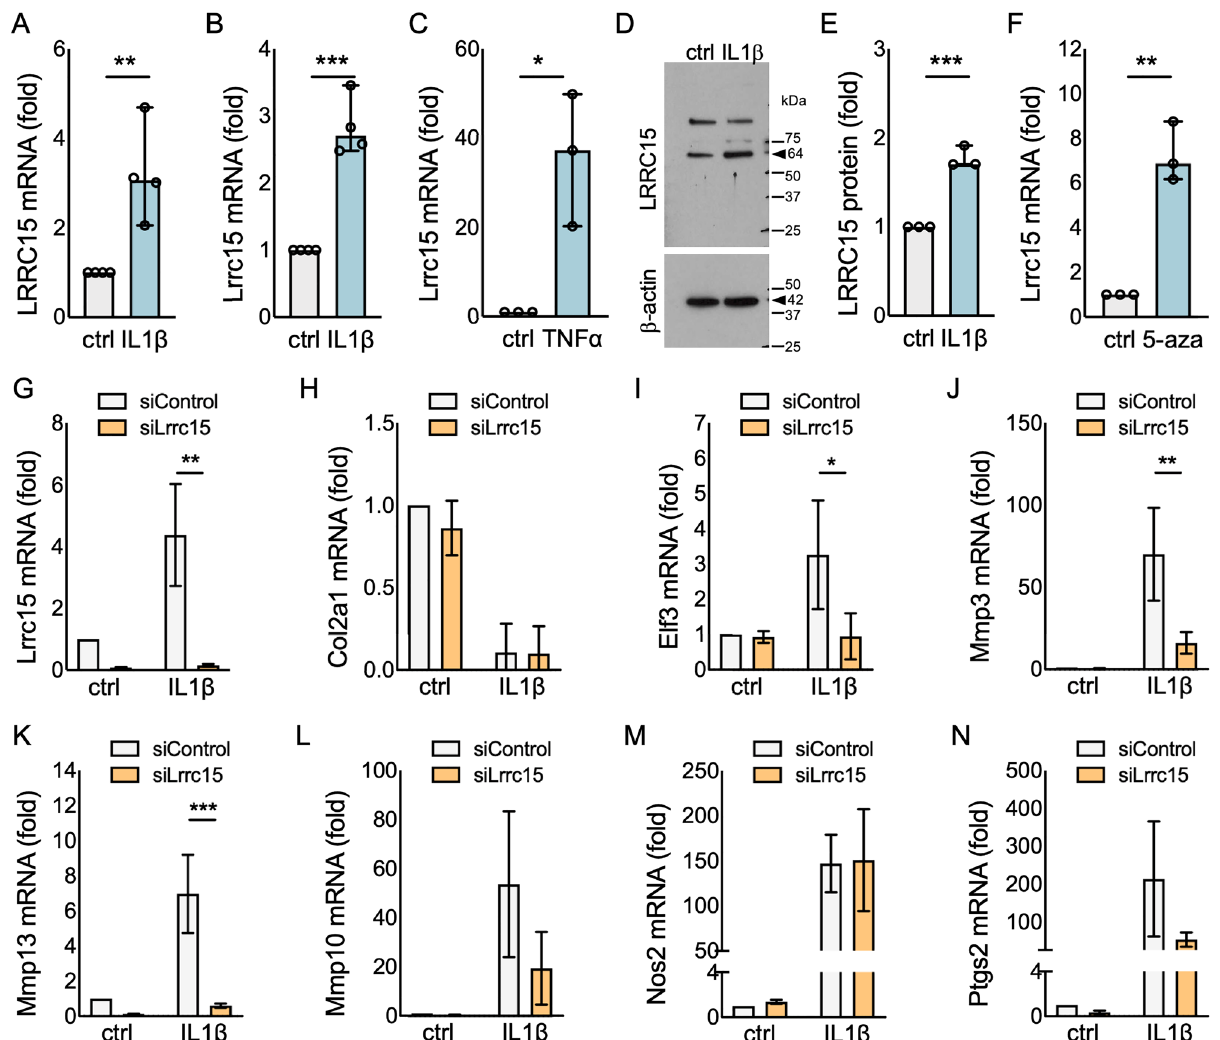
Figure 5. Lrrc15 expression is induced by cytokine stimulation and DNA demethylation, and contributes to the IL-1β-induced gene expression in mouse chondrocytes in vitro. RTqPCR analyses showing ( A ) IL-1β-induced LRRC15 expression in human primary chondrocytes (n = 4), and ( B ) IL-1β-induced (n = 4) and ( C ) TNFα- induced (n = 3) Lrrc15 expression in mouse primary chondrocytes. ( D ) Western blotting analysis of the IL-1β- induced LRRC15 protein in mouse primary chondrocytes. Representative cropped images are shown for clarity and conciseness, and full-length blots are included in the Supplementary Information file. Arrowheads indicate molecular weights for LRRC15 (64 kDa) and β-actin (42 kDa). ( E ) Quantification of the immunoblot (n = 3). ( F ) RTqPCR analyses of mouse chondrocytes (n = 3) treated with 5-Aza-2’-deoxycytidine and trichostatin (labeled as 5-aza) for 72 h, showing increased Lrrc15 expression. Data are shown as fold-change vs. unstimulated controls (set as 1). *p < 0.05, **p < 0.01 and ***p < 0.001 by t-test. RTqPCR analyses in cells transfected with non- targeting control siRNA (siControl) or siRNA against Lrrc15 (siLrrc15), evaluating ( G ) Lrrc15 ( H ) Col2a1, ( I ) Elf3 ( J ) Mmp3, ( K ) Mmp13, ( L ) Mmp10, ( M ) Nos2, and ( N ) Ptgs2 mRNA in cells left untreated (vehicle, ctrl) or treated with 1 ng/ml of IL-1β for 72 h. *p < 0.05, **p < 0.01 and ***p < 0.001 by ANOVA followed by Tukey’s IL-1β treatment led to increased LRRC15 mRNA in human primary chondrocytes (Fig. 5A; see Supplementary Table S7 for RTqPCR primer sequences). We also detected changes in LRRC15 protein in cell lysates from human primary chondrocytes (Supplementary Figure S7). Using murine primary chondrocytes, we confirmed that IL-1β (Fig. 5B) and TNFα (Fig. 5C) treatment induced Lrrc15 mRNA, and that IL-1β led to increased LRRC15 protein (Fig. 5D,E and Supplementary Figure S8). Long-term treatment with cytokines can produce long-lasting changes in gene expression in chondrocytes, at least in part, by changing DNA methylation patterns 42 . Thus, we tested if long-term stimulation of mouse chondrocytes with IL-1β could lead to sustained increases in Lrrc15 mRNA expression. As shown in Supplementary Figure S9, murine chondrocytes treated with IL-1β for 2 weeks maintained increased Lrrc15 expression even after passage and 2 additional weeks of culture with cytokine withdrawal. This observation, together with the hypomethylation of the Lrrc15 gene after DMM (Fig. 3A), sug- gested that changes in DNA methylation may have a functional impact on Lrrc15 transcription. To test this,